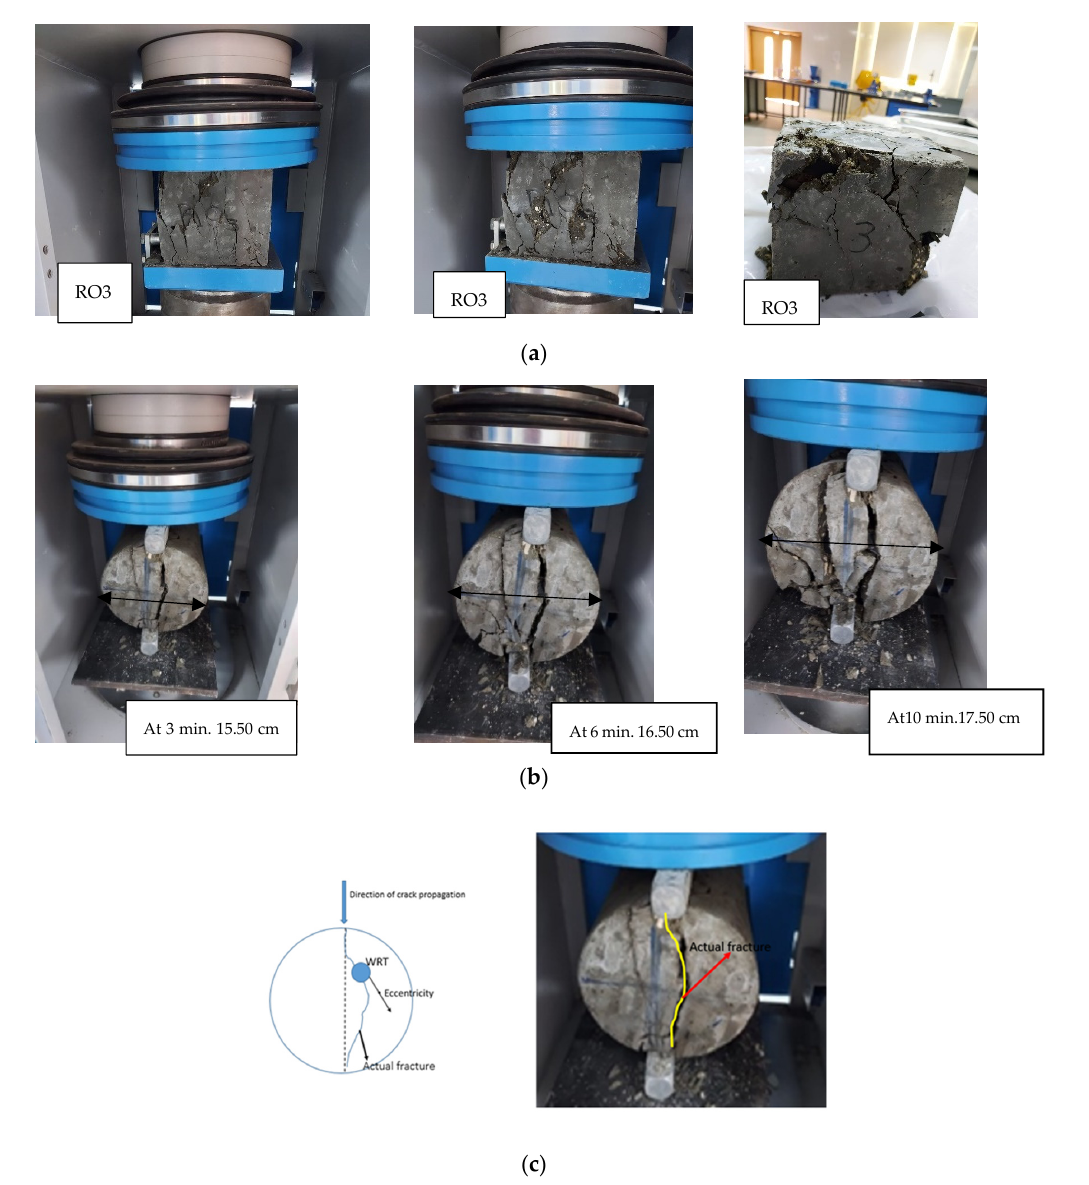
Figure 9. Cracking failure behavior for: ( a ) cubic compressive test (RO3); ( b ) split tensile test (RS6); ( c ) cracking failure and eccentricity effect of WRT split tensile test (RS6).